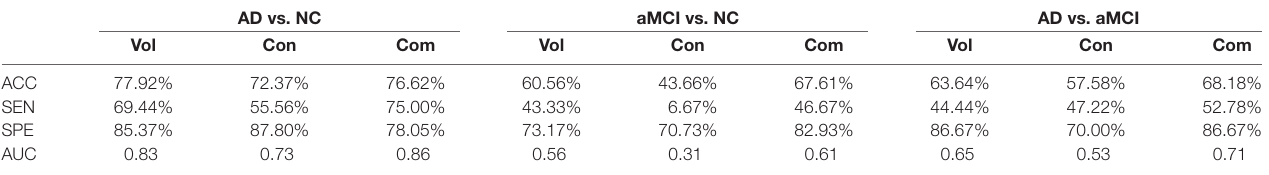
TABLE 3 | Accuracy (ACC) and area under the ROC curve (AUC) by hippocampal volume, structural connectivity (sum of the number of connecting fibers), and their combination in classifying the AD, aMCI, and NC groups. AD vs. NC